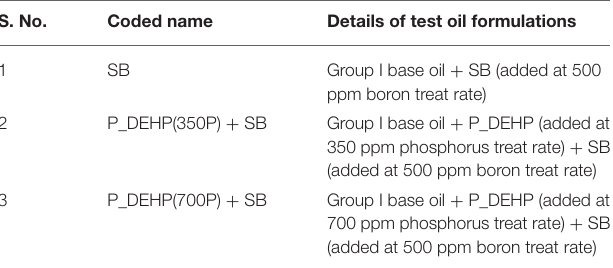
TABLE 2 | Overview of low phosphorus test oil formulations prepared using P_DEHP and SB anti-wear additives. S.